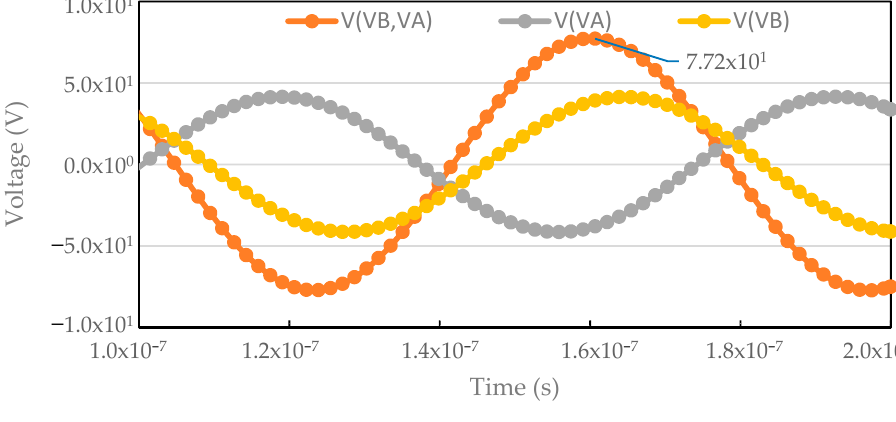
Figure 6. Voltage stress for L 1 = L 2 = 4.74 µH.